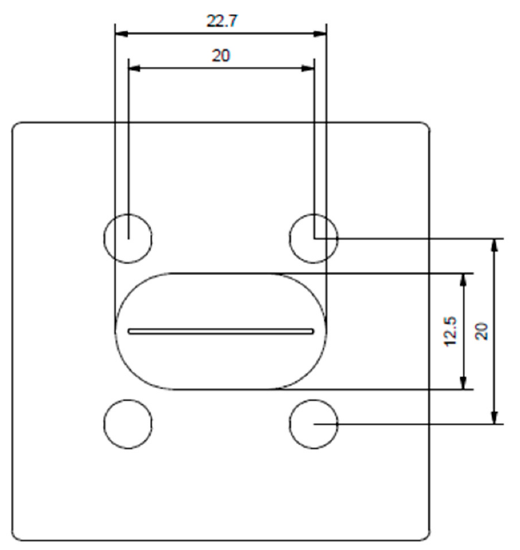
Figure 2. plate nozzle used for plate extrusion (dimension in mm).